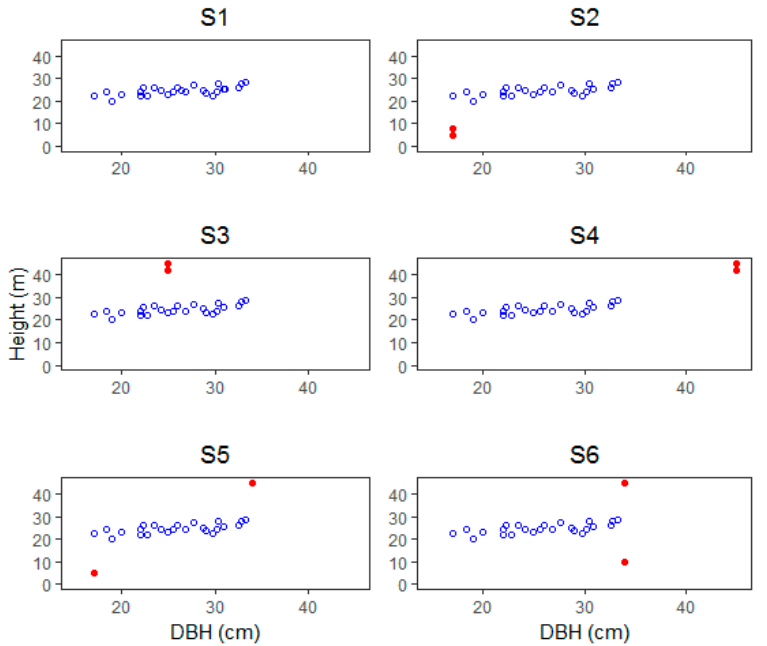
Figure 3. Sensitivity analysis of 6 scenarios (S1 to S6) from a subsample with 26 trees of the same (4.7 years), 5 scenarios containing artificially created outliers (Approach 2) for modeling of height–diameter relationship of O. pyramidale in Ecuador.